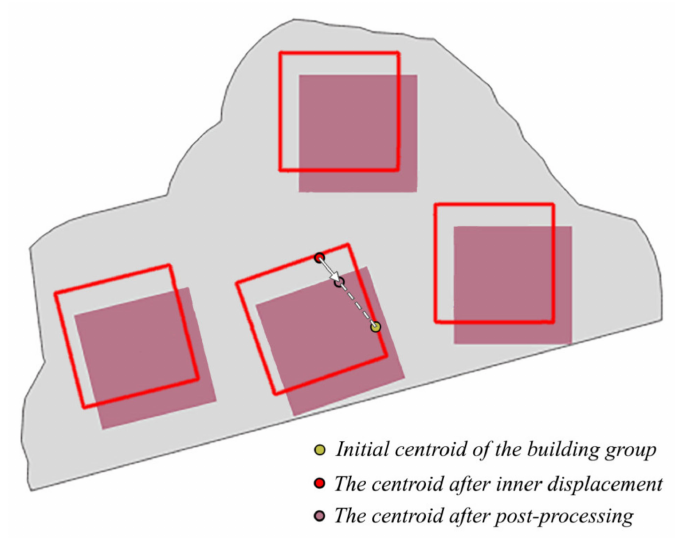
Figure 11. An illustration of the